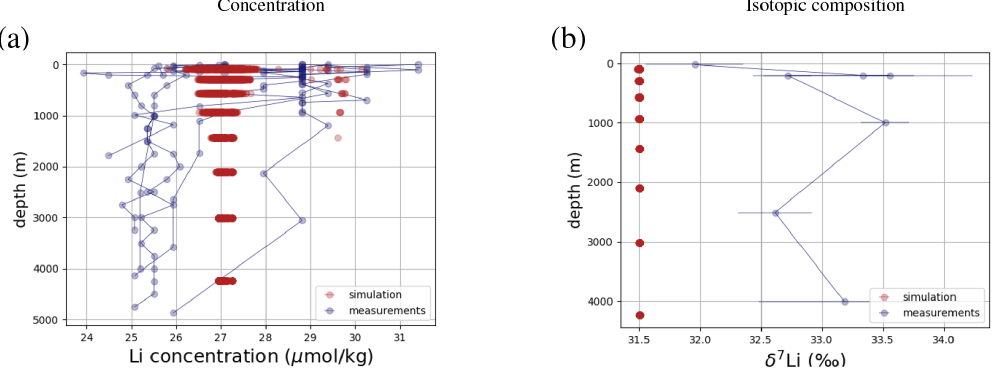
Figure F7. Comparison between measured and simulated Li profiles in seawater. Composites of all available measured Li concentration (a) and isotope ratio (b) profiles and all profiles in the simulation are shown. Data are taken from Angino and Billings (1966), Fabricand et al. (1967), Chan (1987), Chan and Edmond (1988), You and Chan (1996), Moriguti and Nakamura (1998), Tomascak et al. (1999), James and Palmer (2000), Košler et al. (2001), Nishio and Nakai (2002), Hall (2002), Bryant et al. (2003), Pistiner and Henderson (2003), Millot et al. (2004), Choi et al. (2010), and Lin et al. (2016). Li concentrations are normalized to a salinity of 34.90.